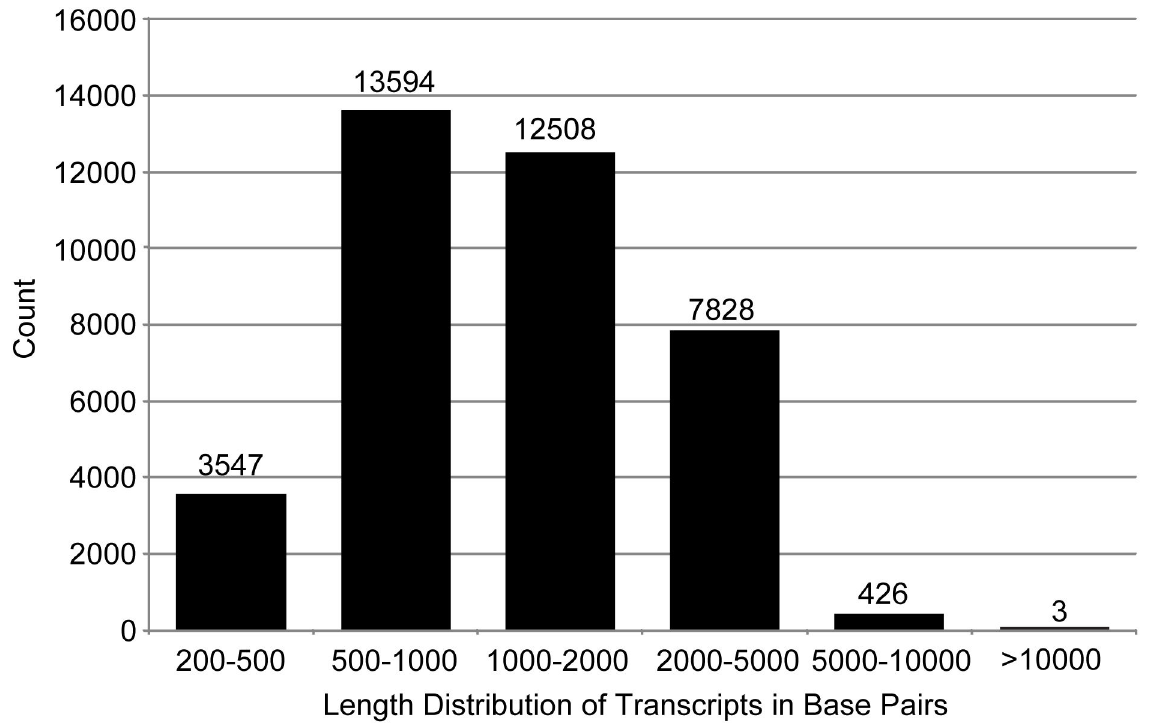
Figure 1. Length distribution of transcripts in base pairs. The numbers of transcripts are shown on top of each bar.